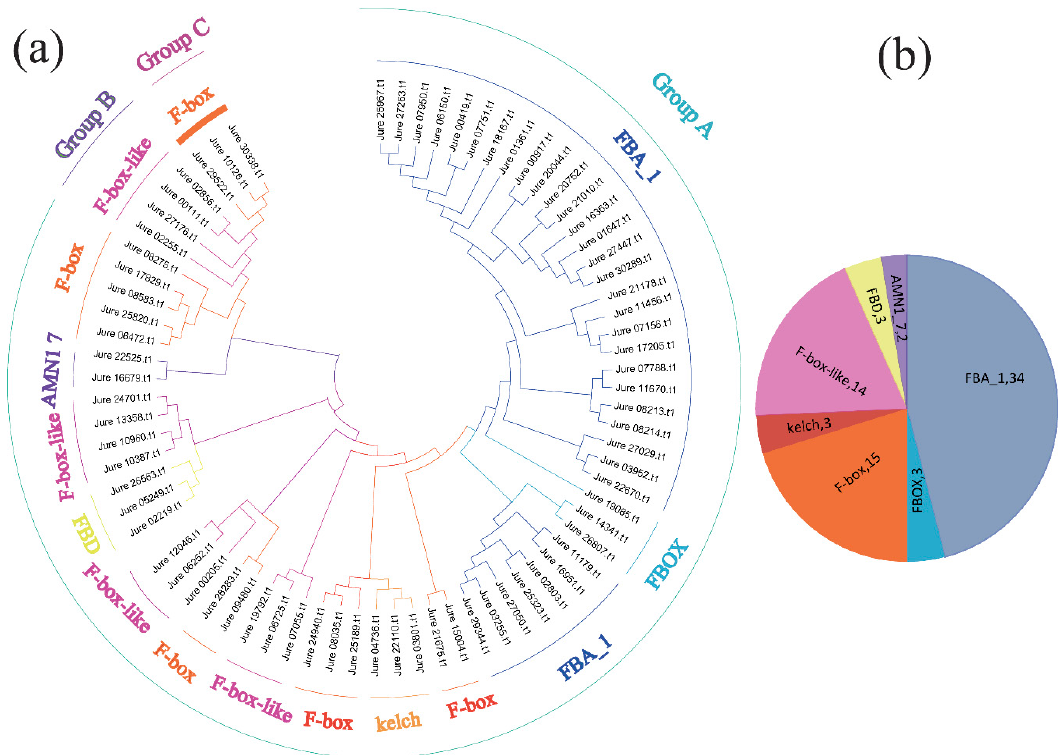
Figure 1. ( a ) Phylogenetic analysis of F-box proteins in common walnut (74). These 74 sequences were used to construct a neighbor-joining (NJ) tree. The tree was divided into eight subfamilies; the names of different groups are displayed. ( b ) The number of each group of the F-box gene family of common walnut.